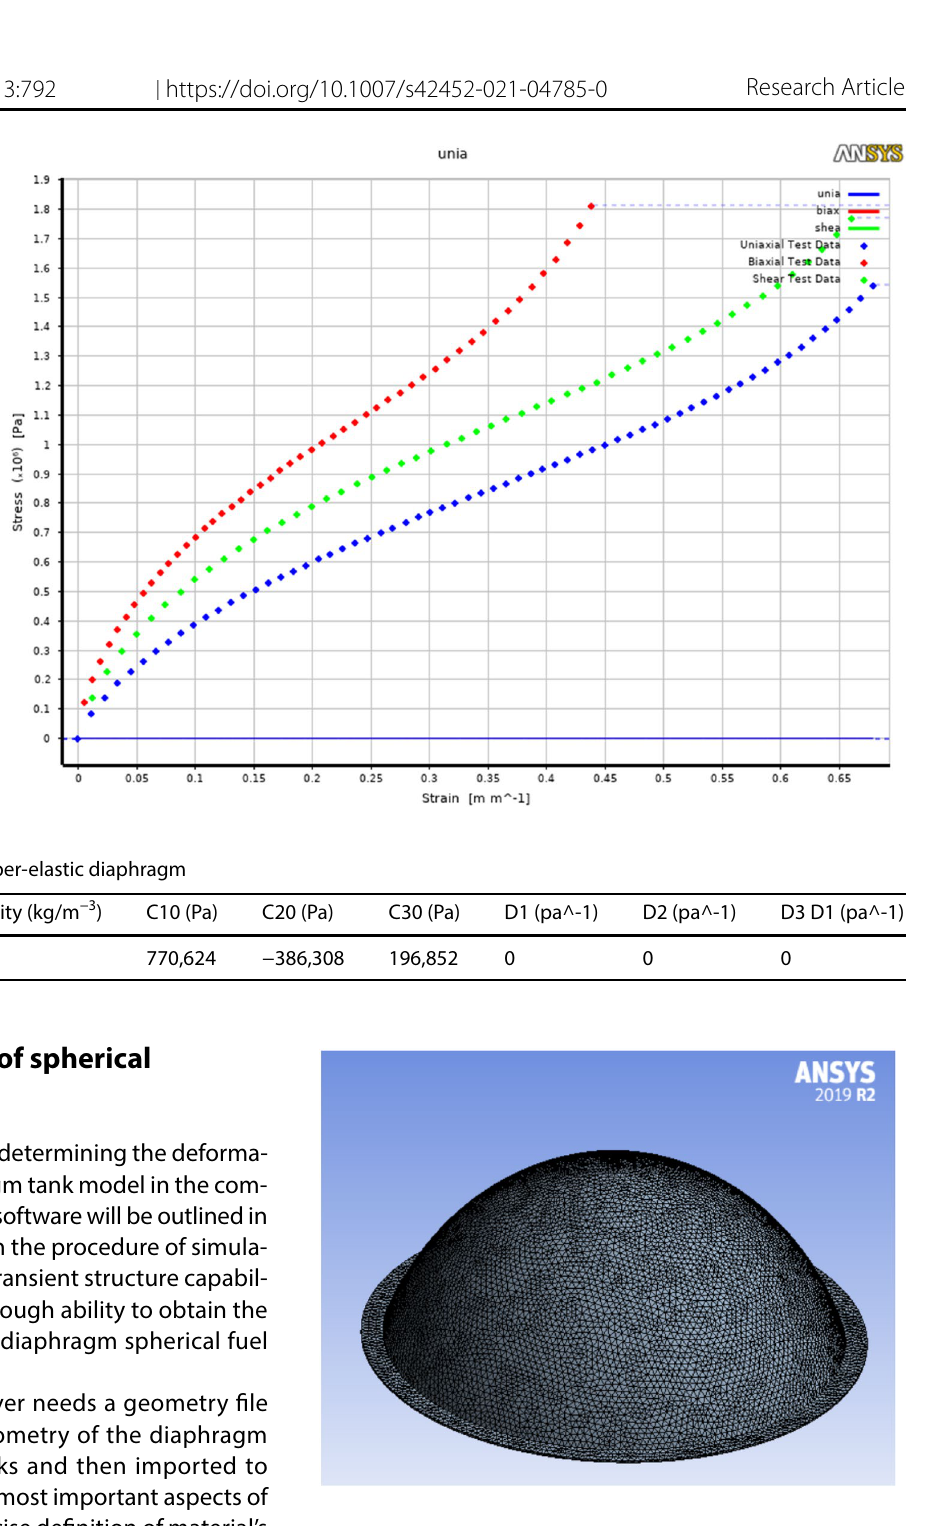
Fig. 8 ANSYS simulation mesh model for elastomer